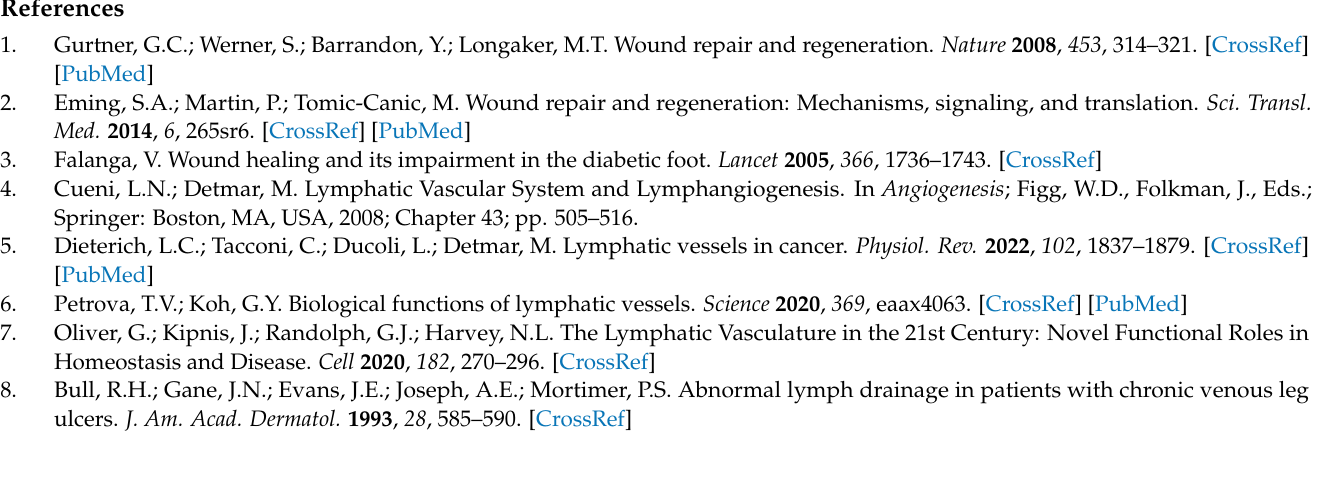
Figure S3: Treatment with F8-SIP and F8–VEGF-C has no effect on LVs in unwounded diabetic skin; Figure S4: Gene set enrichment analysis (GSEA) from whole-wound RNA bulk sequencing of F8-SIP- and F8–VEGF-C-treated diabetic mice; Table S1: Patient information for human chronic wound